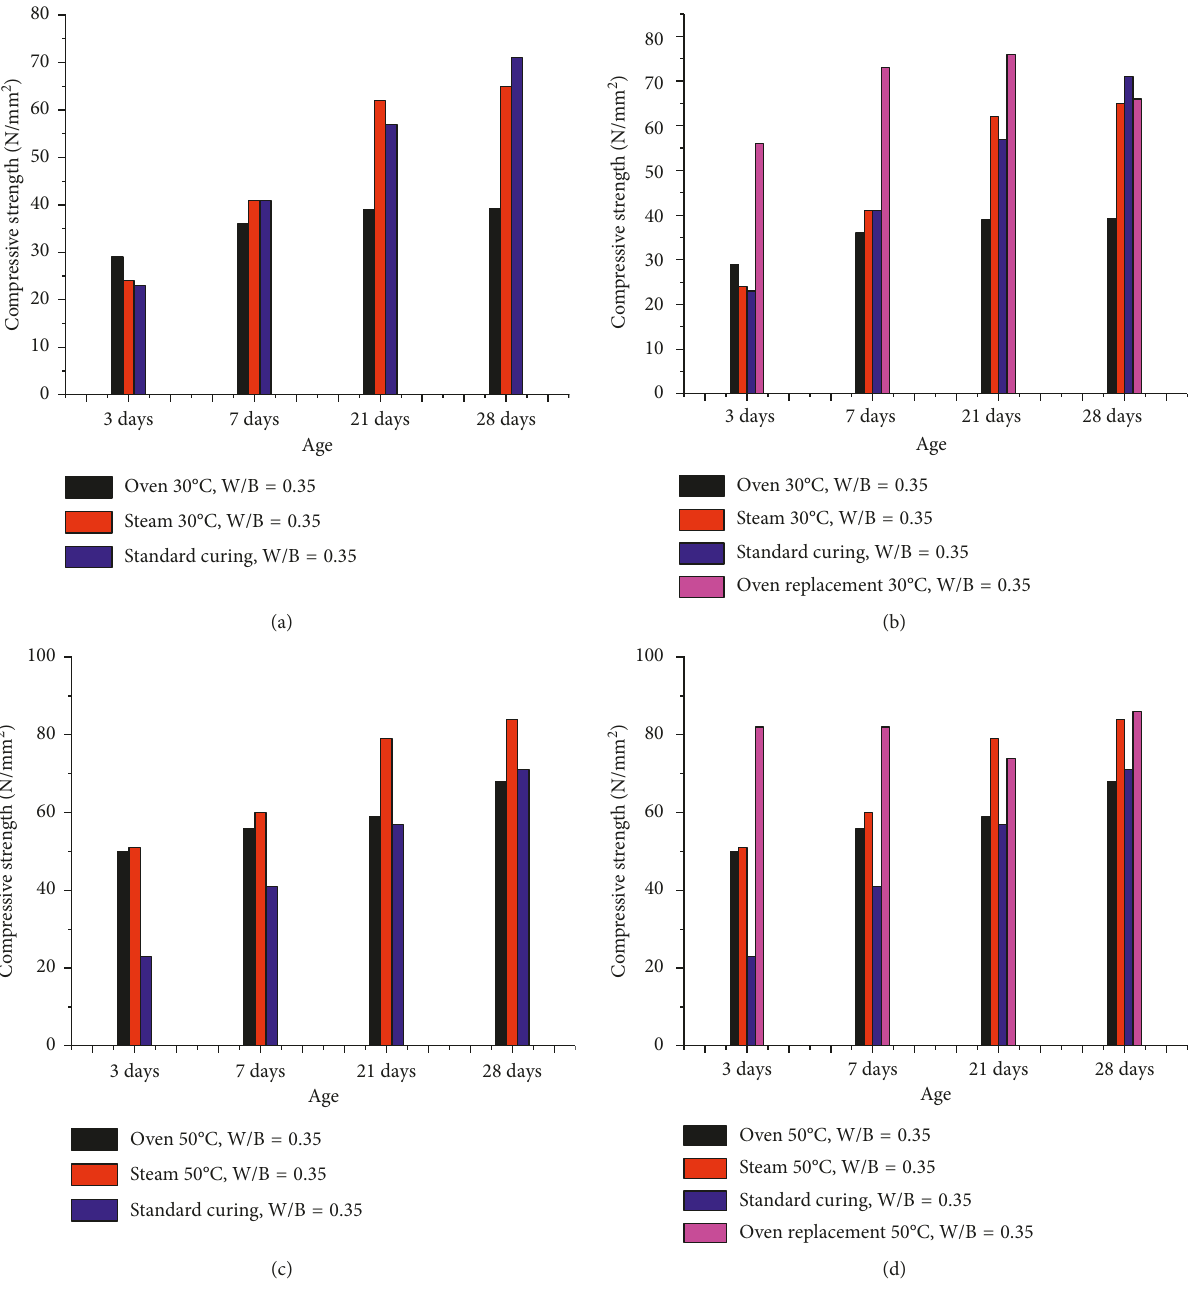
Figure 2: (a) Compressive strengths of concrete specimens with a W/B ratio of 0.35 prepared and cured under different conditions at a temperature of 30 ° C. (b) Compressive strengths of concrete specimens with a W/B ratio of 0.35 prepared and cured under oven replacement compared with different conditions at a temperature of 30 ° C. (c) Compressive strengths of concrete specimens with a W/B ratio of 0.35 prepared and cured under different conditions at a temperature of 50 ° C. (d) Compressive strengths of concrete specimens with a W/B ratio of 0.35 prepared and cured under oven replacement compared with different conditions at a temperature of 50 °